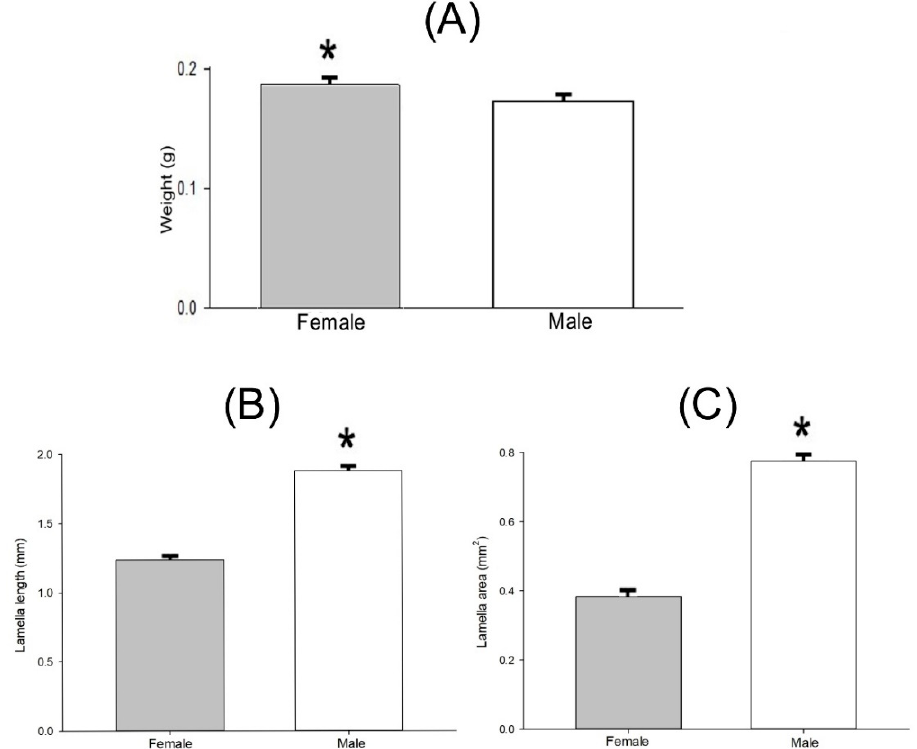
Figure 15. Mean ± SEM of weight ( A ), lamella length ( B ), and lamella area ( C ) of lab-reared males and females of Cyclocephala barrerai adults. t -test, * = significance